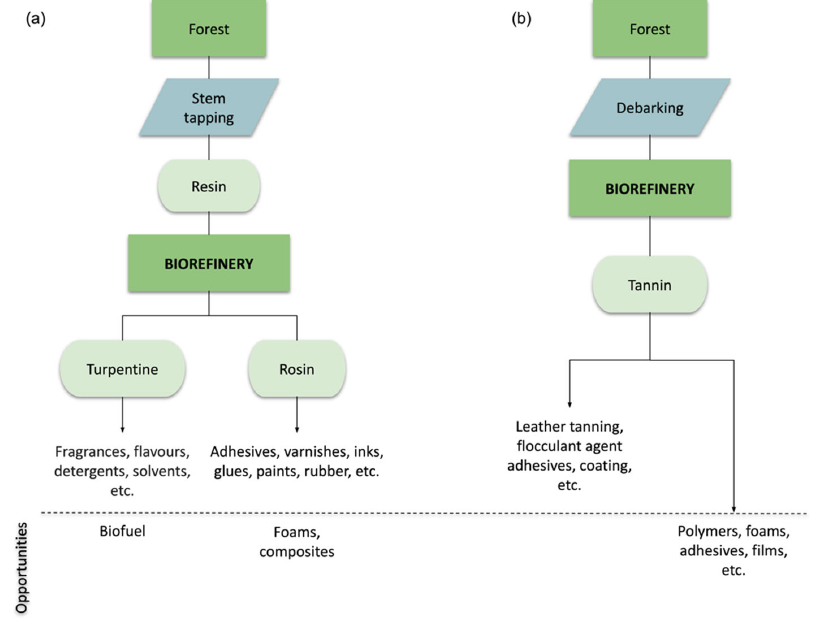
Figure 4. Simplified value chains for ( a ) tree resin and ( b ) tannins from the Brazilian planted tree industry.